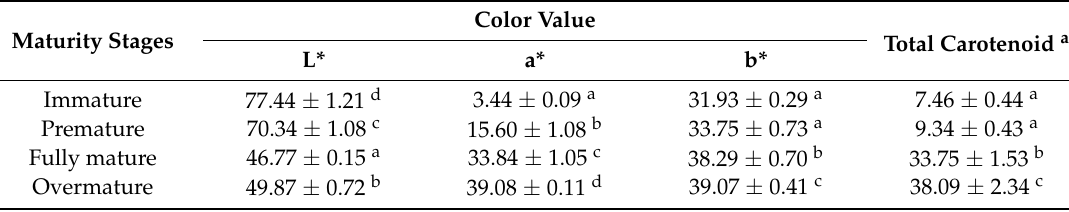
Table 6. Color and total carotenoid content at different maturity stages of M. tricuspidata